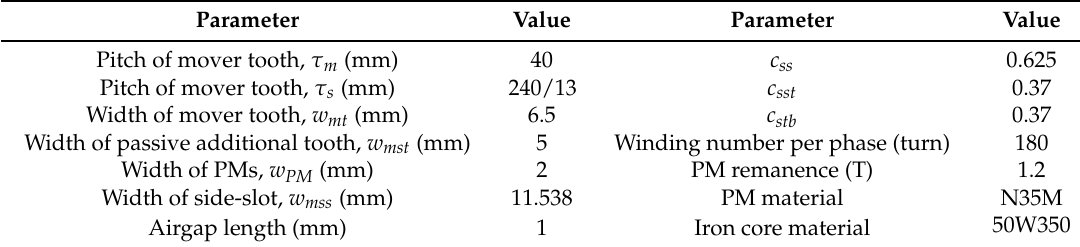
Table 2. Key parameters of the proposed machine.